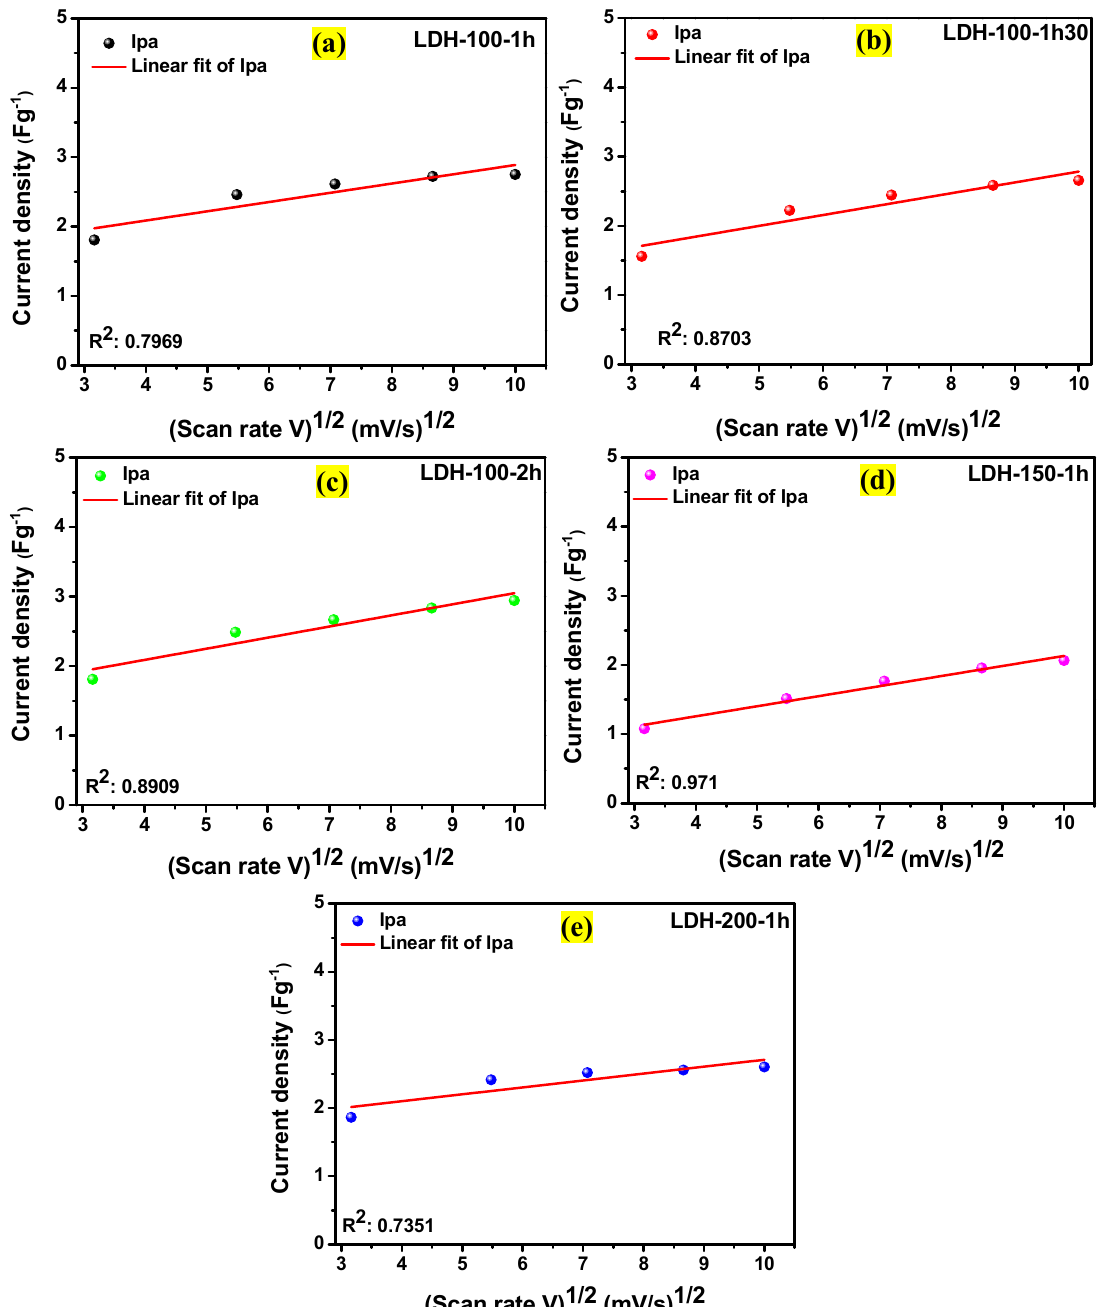
Figure 7. Dependence of the anodic peak current (ipa) on the square root of the scan rate for the ( a ) LDH-100-1h, ( b ) LDH-100-1h30, ( c ) LDH-100-2h, ( d ) LDH-150-1h, and ( e ) LDH-200-1h electrodes, respectively.